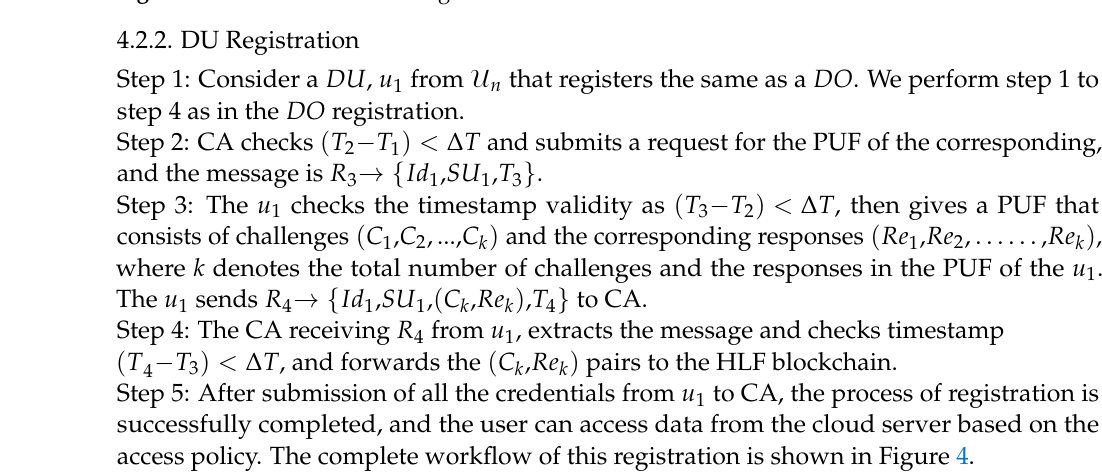
Figure 3. Workflow of the DO